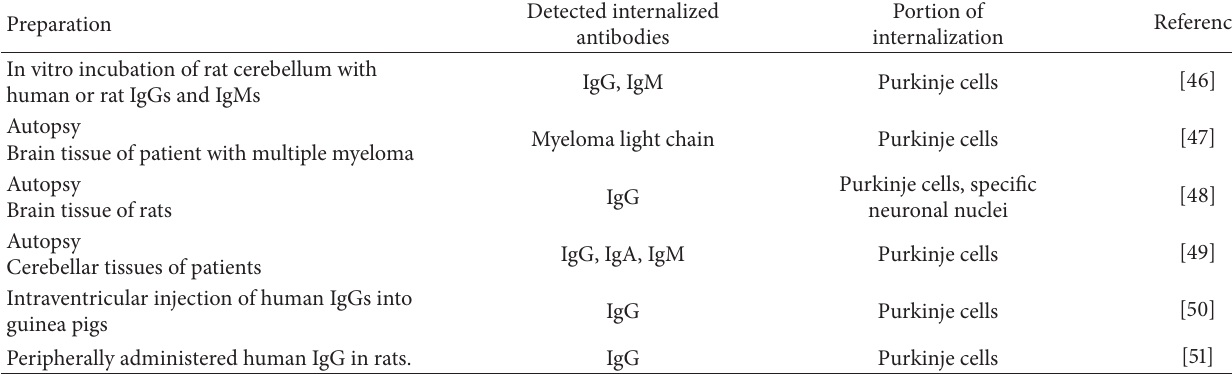
Table 2: Summary of experiments showing internalization of antibodies into cerebellar